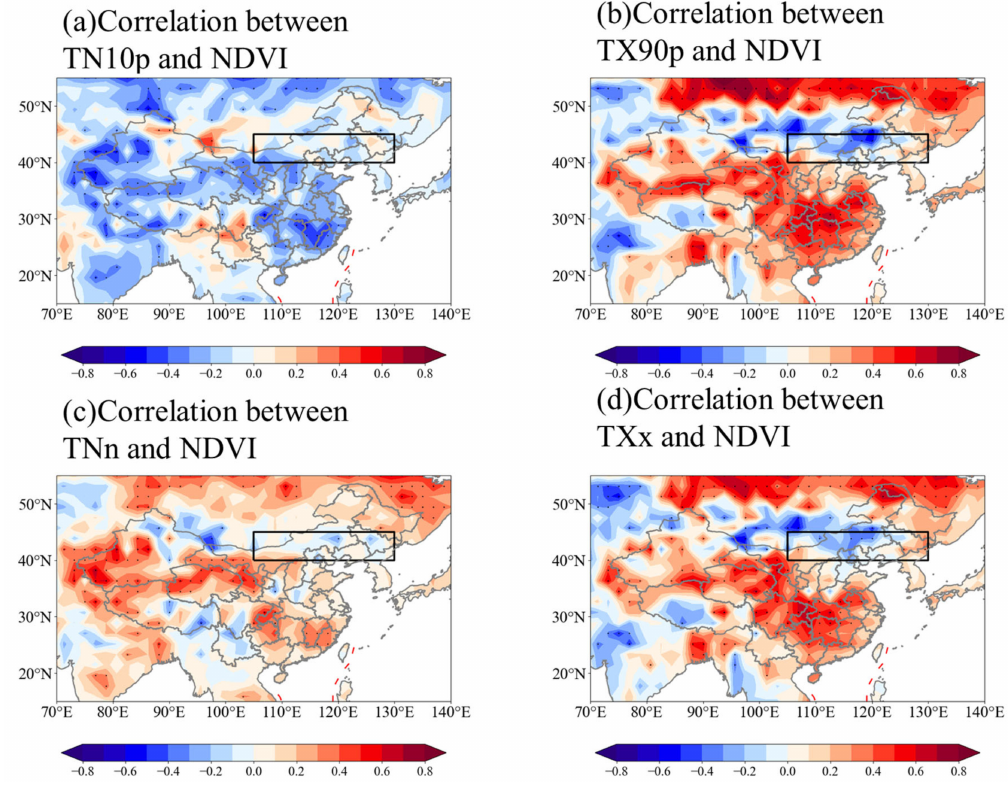
Figure 10. Spatial correlations (grid-to-grid correlation) between NDVI and four extreme indexes related to temperature: ( a ) TN10p (%)–NDVI, ( b ) TX90p (%)–NDVI, ( c ) TNn ( ◦ C)–NDVI, and ( d ) TXx ( ◦ C)–NDVI. Note: red represents positive correlation, blue represents negative correlation. The red dashed lines in the figure represent Ten-dashed lines. The numbers below the description of the colors represent the spatial correlation coefficients. The black box in it is defined as the north- eastern region of East Asia (40~45 ◦ N, 105~130 ◦ E). Note: dots represent correlations significance at p < 0.1, and in the dotted areas, the effective degree of freedom varies spatially between